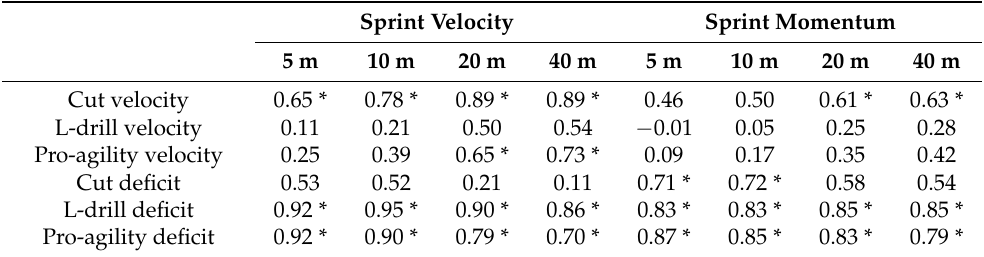
Table 7. Correlation coefficients between change of direction velocity and deficit for the three distinct protocols and sprint velocity and momentum over the different distances.